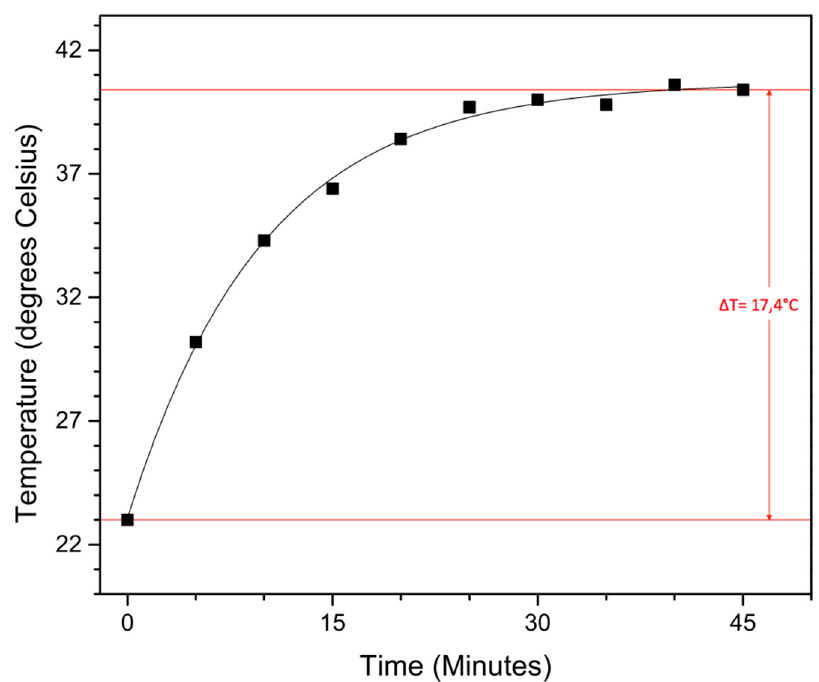
Figure 6. Time-dependent temperature rise from magnetic heating experiments conducted in a 50 Gauss magnetic field (48, 55 kHz) with a 20 nm nanoparticle solution of 0.5 mg/mL in water.